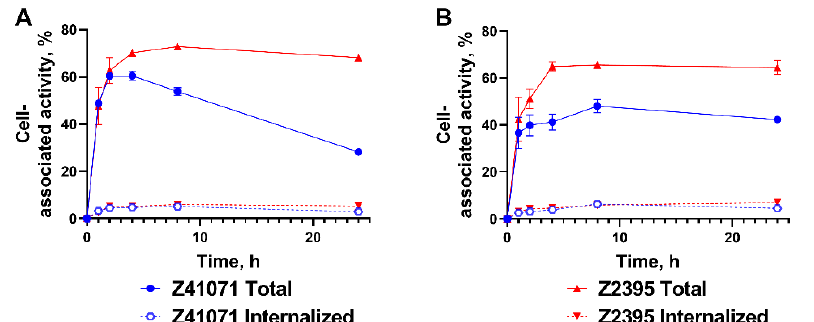
Figure 3. Binding and cellular processing of 188 Re-ZHER2:41071 and 188 Re-ZHER2:2395 by HER2- expressing SKOV-3 ( A ) and SKBR-3 ( B ) cells. Data are presented as an average ( n = 3) value ± SD.